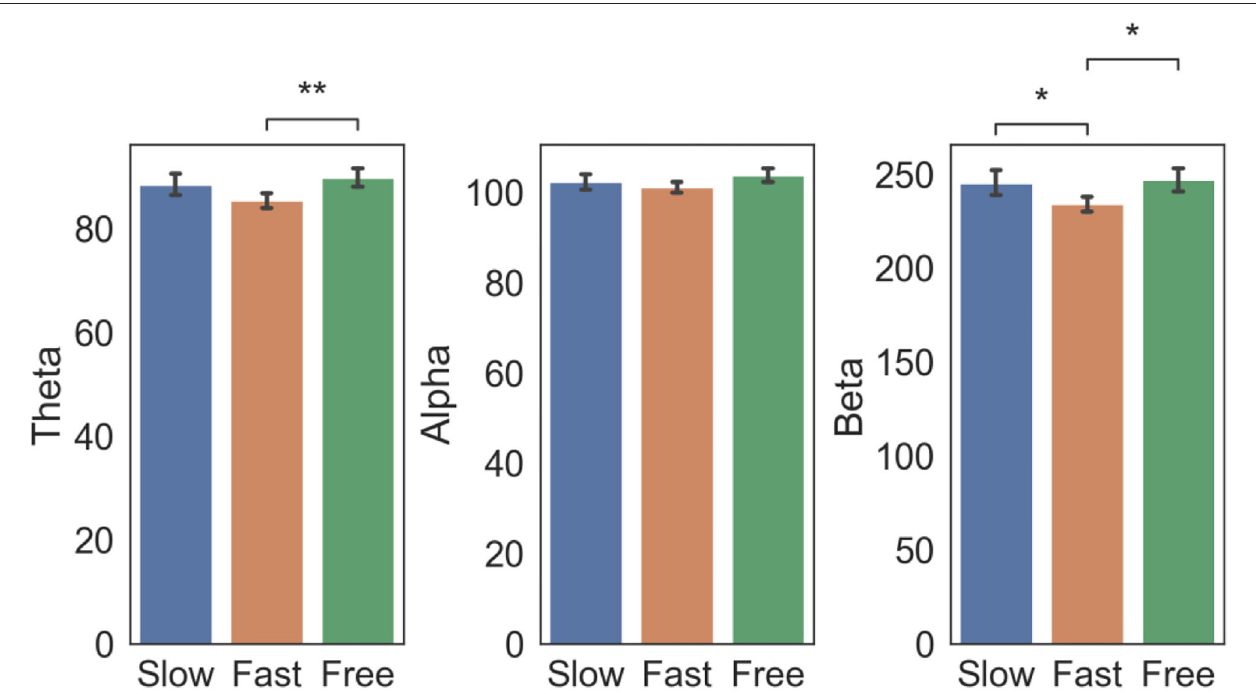
FIGURE 4 | Controlled paradigm: EEG power changes as a function of subjective time condition. EEG power (mean ± std across electrodes Fp2, C4, P4, and O2) in the Theta, Alpha and Beta bands in epochs corresponding to Slow, Fast and Free condition. Square brackets indicate significant differences as assessed with pair-wise Welch t -test (* p < 0.05, ** p < 0.01, Bonferroni